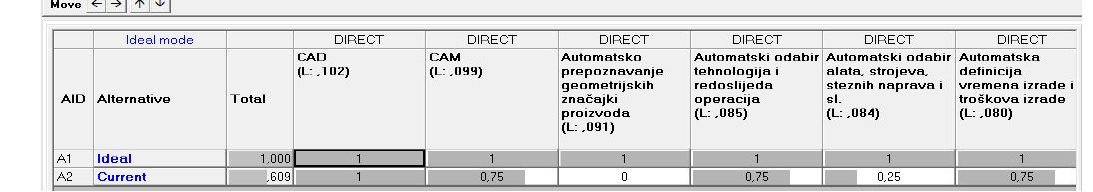
Figure 8. Single element (criterion) evaluation—data input.